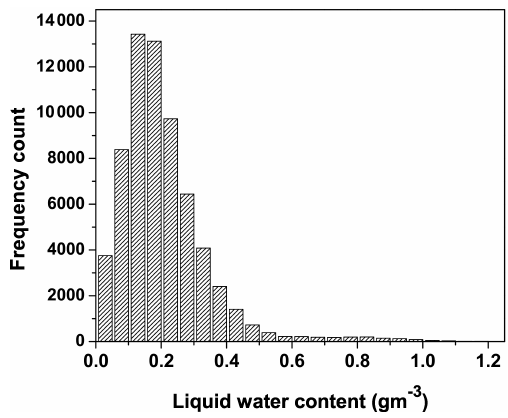
Figure 4. Frequency distribution plot of the measured LWC. Fig. 5, the aerosol indirect effect and dispersion factor for the mentioned LWC ranges are represented, in which the green line corresponds to AIE s , the black line to AIE n , and the blue line to dispersion factor.